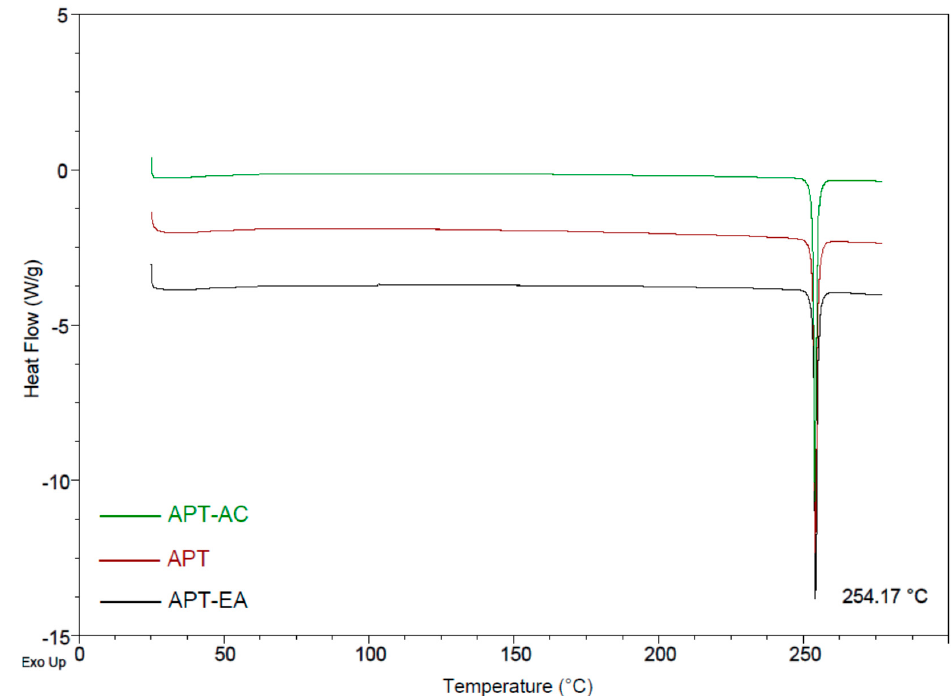
Figure 2. DSC thermogram overlay.